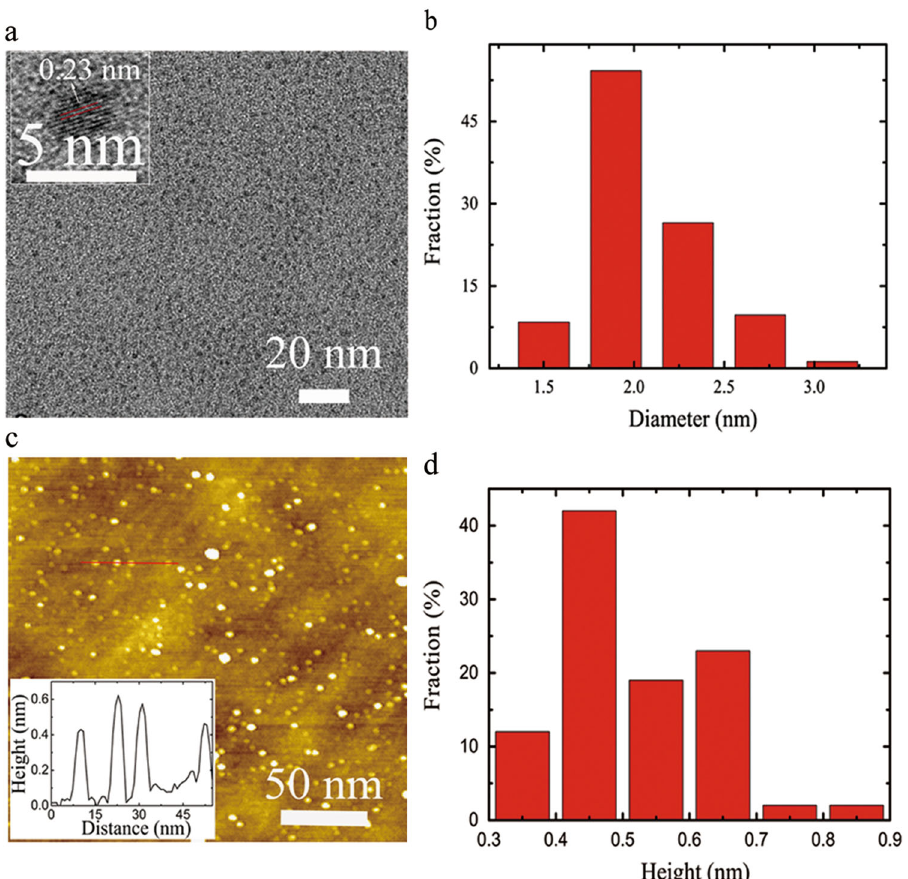
Fig. 2 a TEM image of GQDs. The upper left inset is HRTEM image. b The diameter distribution of GQDs. c AFM image of GQDs. The lower left inset is the height pro fi le of the red line . d The height distribution of